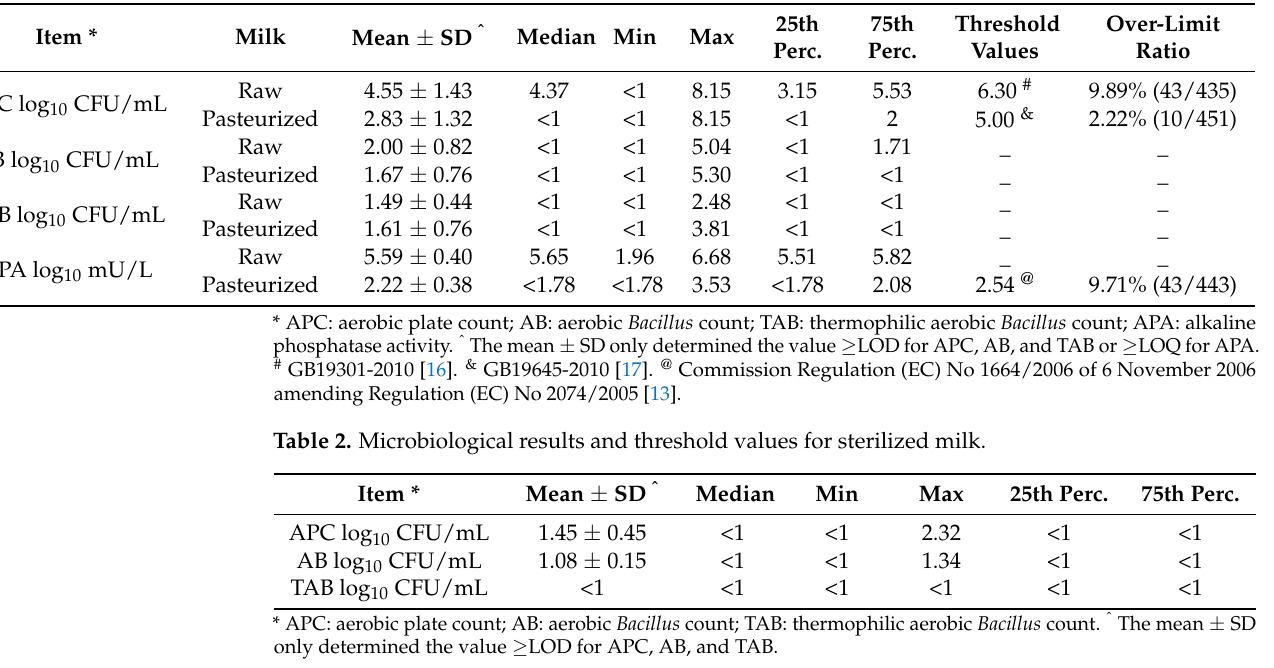
Table 1. Microbiological results and threshold values for raw and pasteurized milk.